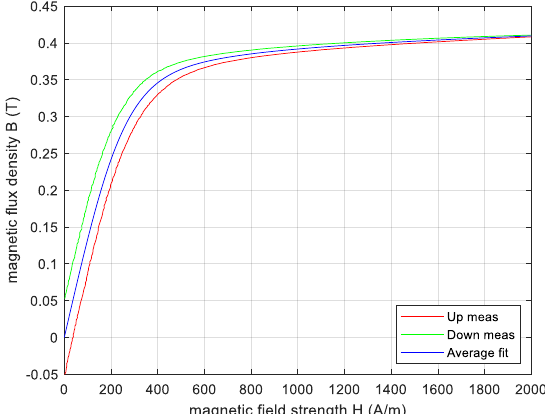
Figure 6. Measured equivalent B ( H ) of the T2 supplied with C and A windings: upward curve (red), downward curve (green) and interpolated anhysteretic curve (blue). downward curve (green) and interpolated anhysteretic curve